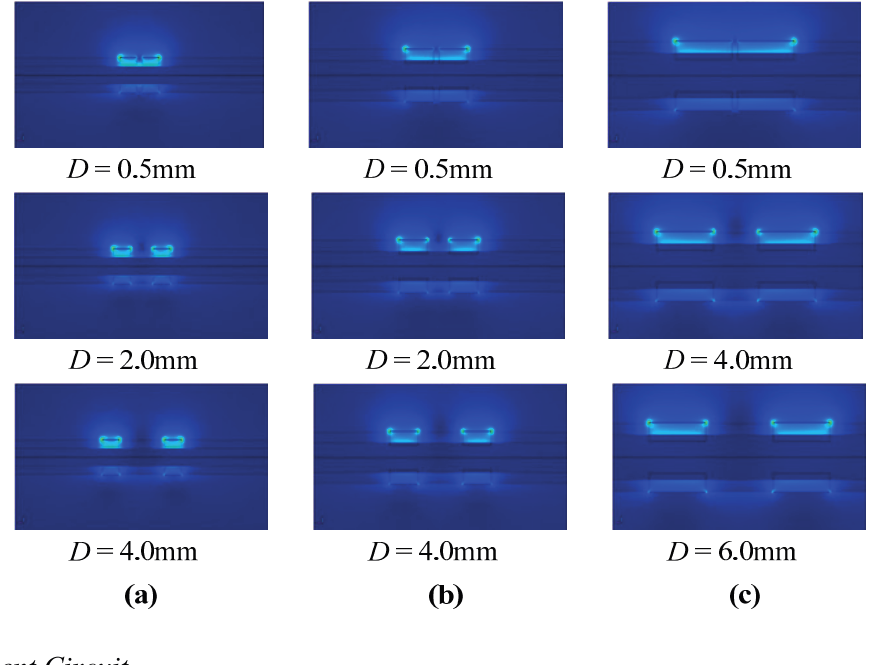
Figure 2. Electrical field simulations of two capacitance sensors: ( a ) Electrical field distribution in 1.56 mm inner diameter pipe with 3.0 mm outer diameter; ( b ) Electrical field distribution in 2.65 mm inner diameter pipe with 4.56 mm outer diameter; ( c ) Electrical field distribution in 3.96 mm inner diameter pipe with 6.0 mm outer